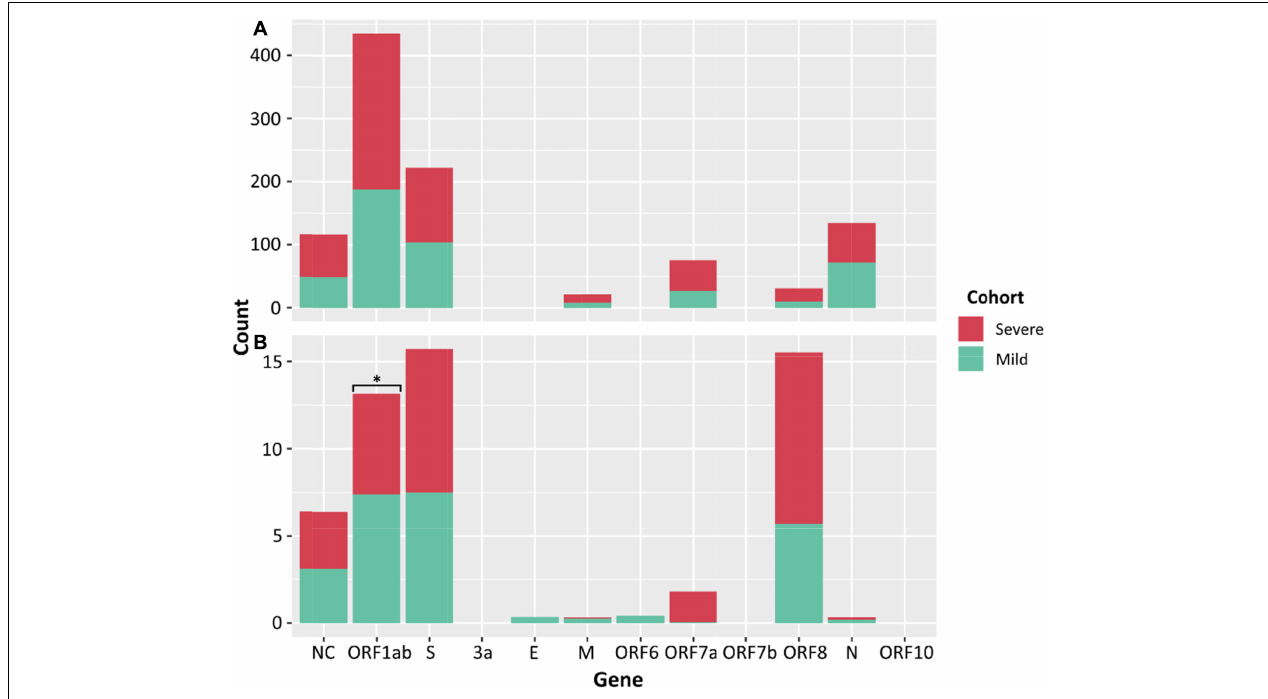
FIGURE 4 | Counts of SNPs (A) and iSNVs (B) by SARS-CoV-2 gene for severe (red) and mild (green) cohorts. Frequencies ≥ 0.9 were considered SNPs. Problematic sites are not included. Statistical significance ( p ≤ 0.05) is denoted by ( ∗ ) and NC signifies non-coding region of the genome. The number of iSNVs in the ORF1ab gene of SARS-CoV-2 were significantly different between the severe and mild